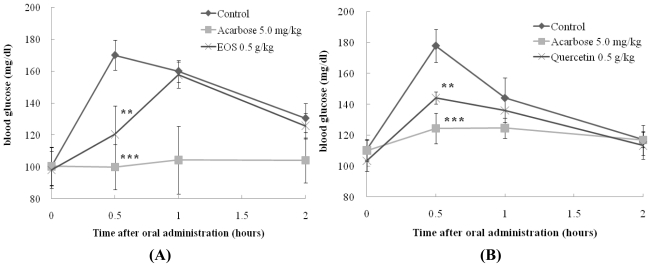
Effect of EOS (A) and quercetin (B) on sucrose loading test. After fasting for 24 h, 5-week-old, male SD rats were orally administered with sucrose solution (2.0 g/kg) with or without samples (EOS, Ethyl alcohol extract of onion skin: Positive control: Acarbose). Each point represents mean ± S.D. (n = 5). *p < 0.05, **p < 0.01, and ***p < 0.001 compared to different samples at the same concentration by unpaired Student’s t-test. (A) (B)